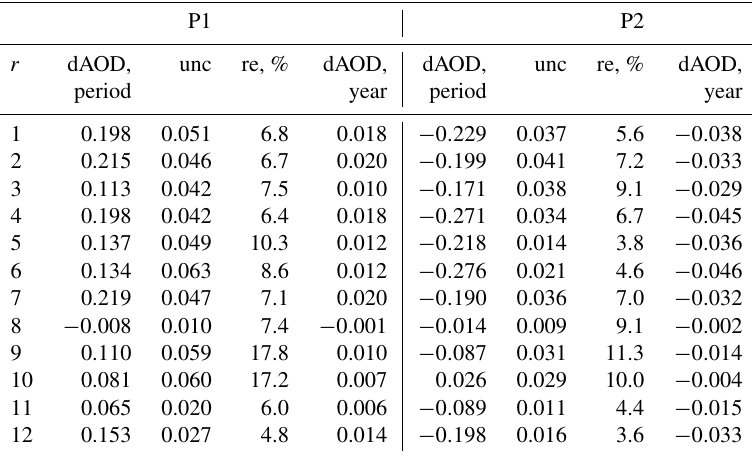
Table A2. AOD tendency (dAOD) per year and statistics for the annual combined AOD time series linear fit ( p -value, bias, slope, uncertainty and relative error – re, %) for two periods: P1 (1995–2006), and P2 (2011–2017) for the different regions ( r , where region 11 is all of mainland China and region 12 is mainland SE